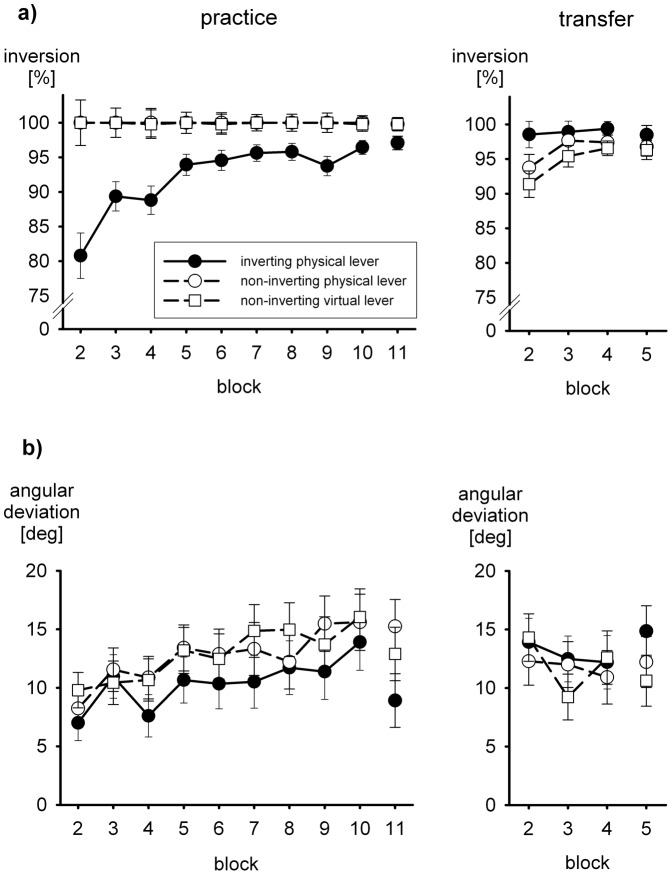
Mean percentage of movements with right-left inversion (a) and mean angular deviation (b) during practice and transfer.Error bars represent standard errors.